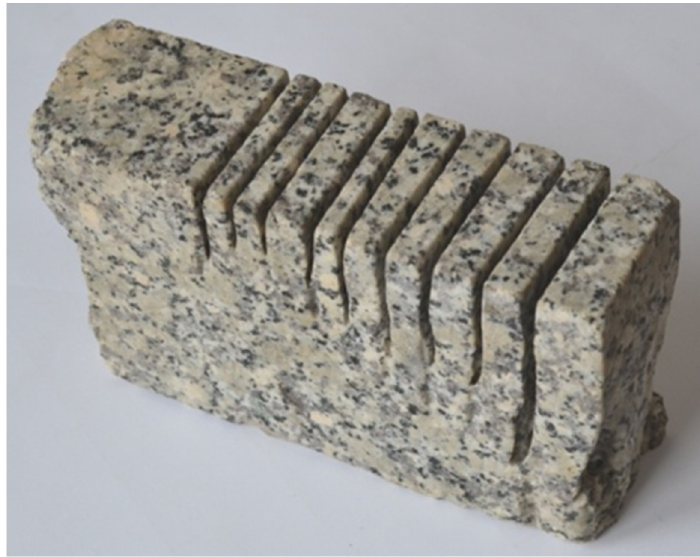
Figure 1. Granite from the Strzegom quarry.